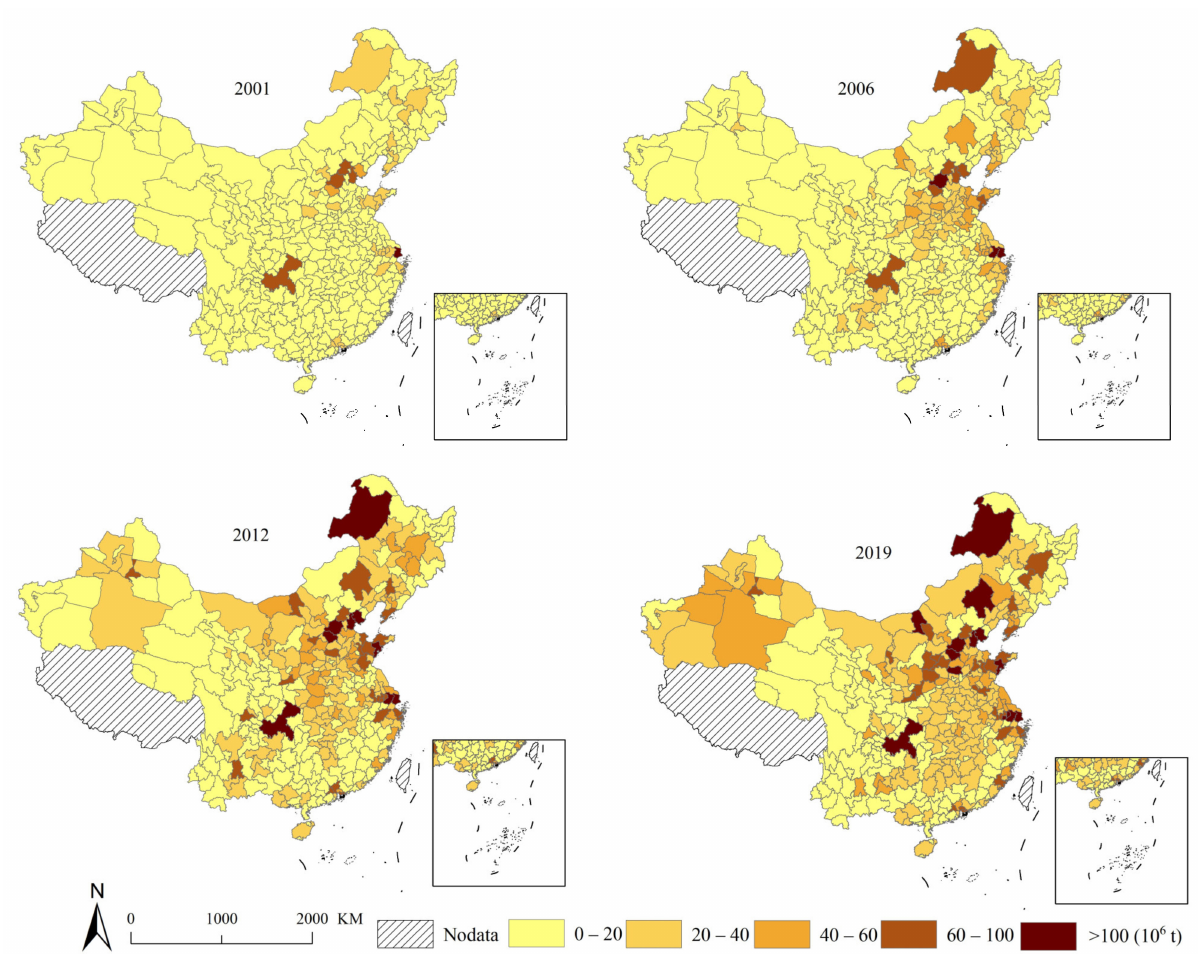
Figure 6. Spatial distribution of city-level carbon emissions from 2001 to 2019.